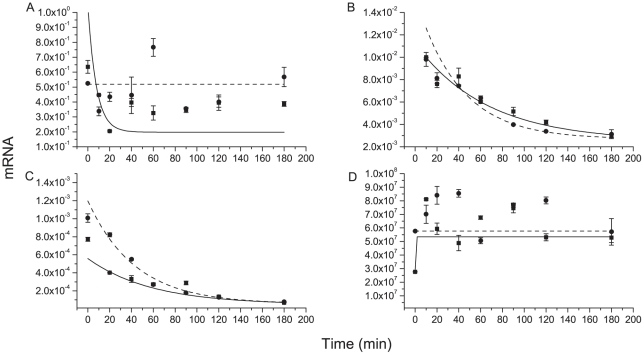
mRNA decay of L. (L.) amazonensis total mRNA.Relative copy-numbers of: A. 5.1 AAP3 mRNA transporter, B. 4.7 AAP3 mRNA transporter, C. GAPDH mRNA and D. SSUrRNA. A, B and C were normalized by SSUrRNA. The black line represents the exponential decay fit of actinomycin + sinefungin-treated samples in presence of 400 µM arginine. The discontinuous line represents the exponential decay fit of actinomycin + sinefungin-treated samples in absence of arginine. Fit lines for B and C have R2>0.90. Data of a representative experiment shown as the mean±S.E. (n = 3).